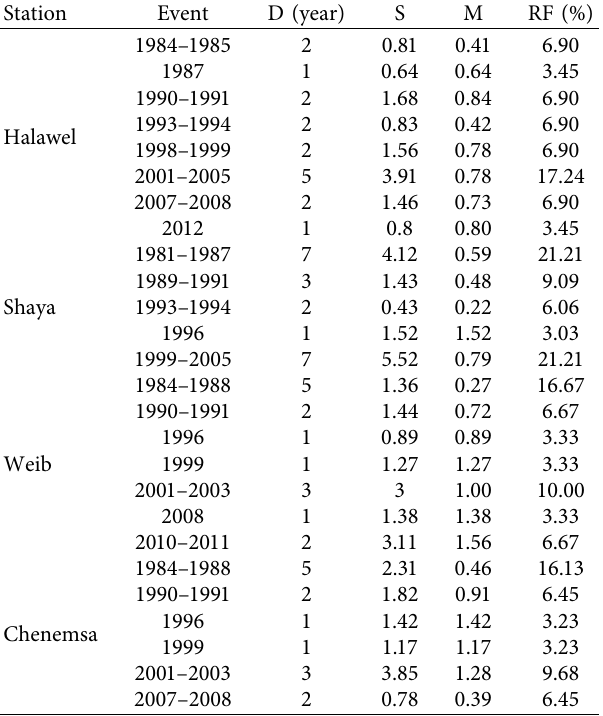
Table 11: Hydrological drought characterization in Ethiopian major river basins, Genale Dawa river basin. Station